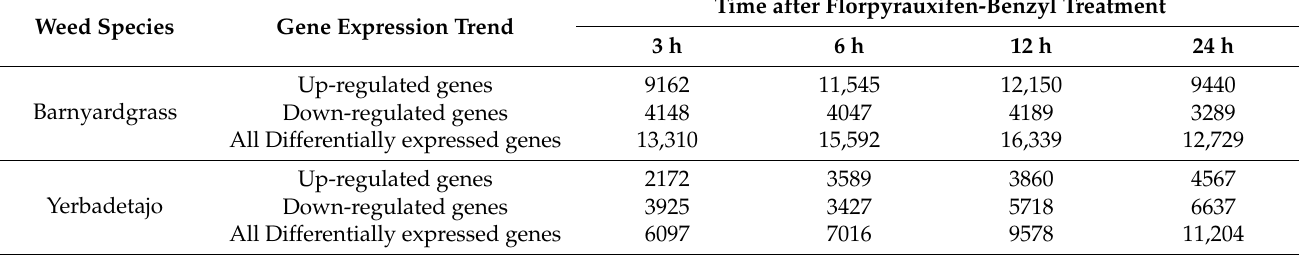
Table 4. Differentially expressed genes compared to untreated control after florpyrauxifen-benzyl treatment in barnyardgrass and yerbadetajo.